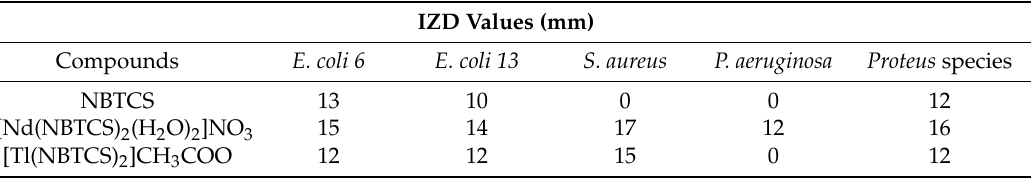
Table 4. Antibacterial activity of NBTCS, [Nd(NBTCS) 2 (H 2 O) 2 ]NO 3 and [Tl(NBTCS) 2 ]CH 3 COO.